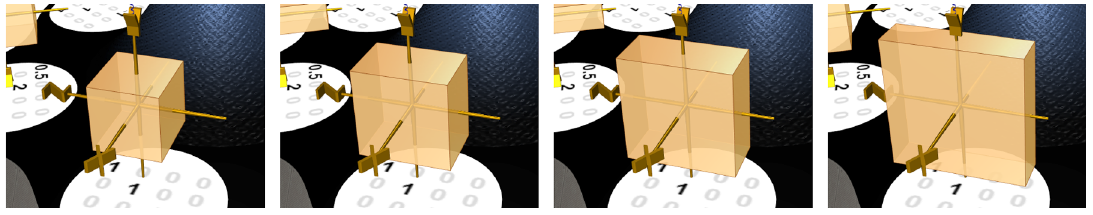
Figure 15. Transformation of a